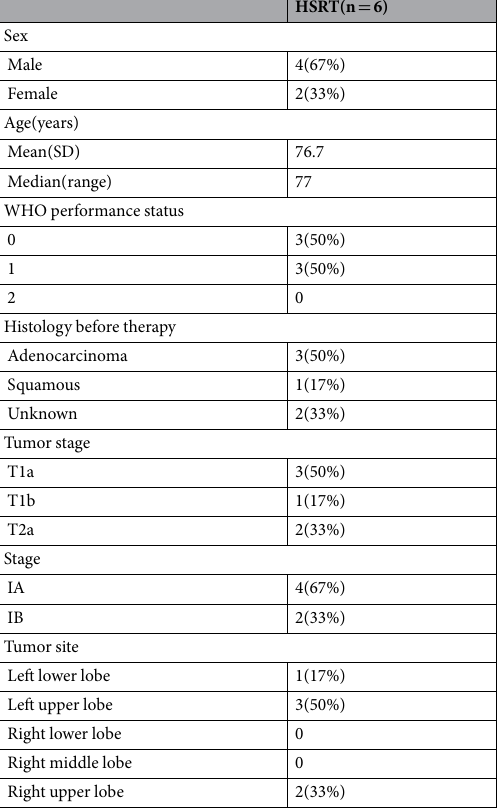
Table 1. Patient demographics. Data are n (%) unless otherwise stated. HSRT, hypofractionated stereotactic